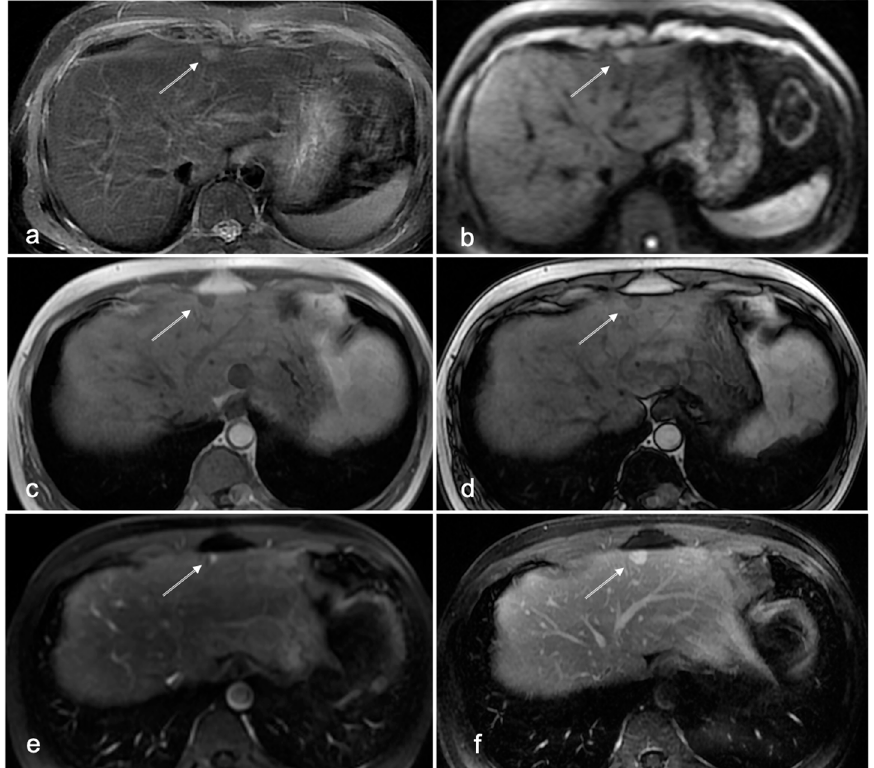
Figure 4. Forty-one-year-old male patient with chronic HBV infection, without clear signs of cirrho- sis. On NC-AMRI axial T2W, FS images ( a ) and DWI ( b ) show a mildly hyperintense lesion subcap- sular in segment 4 (arrow). The lesion is hypointense on T1W in-phase ( c ) and opposed-phase ( d ) images. This lesion was interpreted as suspect for HCC by all readers. On CE-MRI, however, dy- namic contrast-enhanced sequences showed characteristic peripheral nodular enhancement in the arterial phase ( e ) with persistent enhancement in the delayed phase ( f ) compatible with a benign lesion: